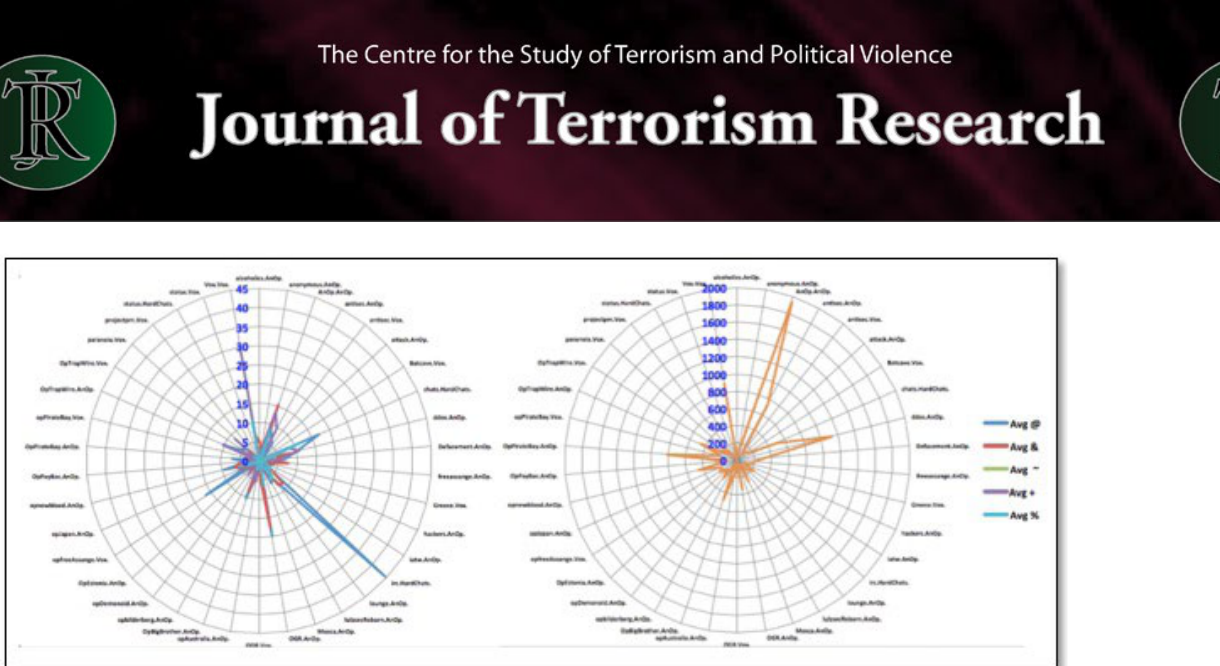
Figure 7: Two visualisations of the average privileged and non-privileged nicks active within the same channels (note the scale shown in blue on each